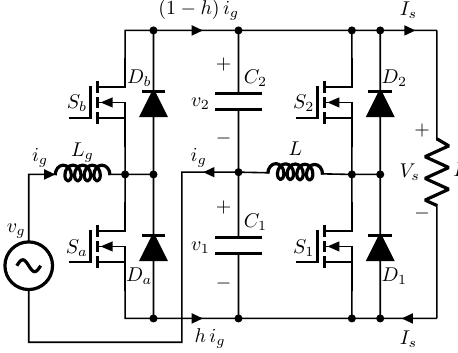
Figure 3. Voltage doubler boost rectifier with